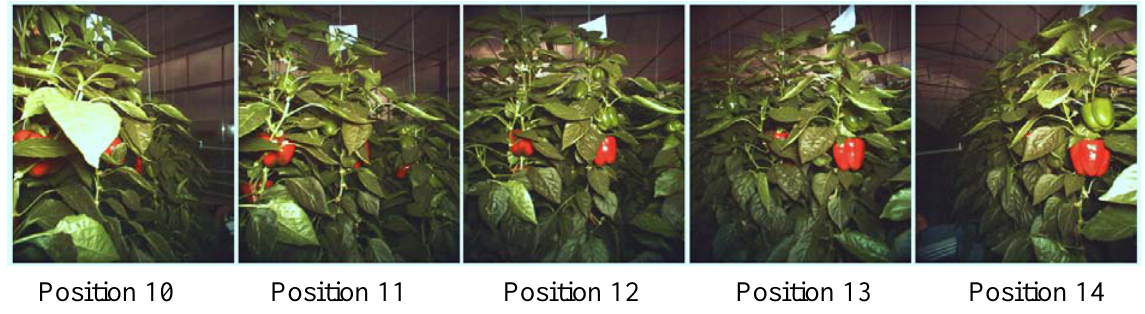
Figure 4. Example images from the same plant taken from different camera viewpoints.